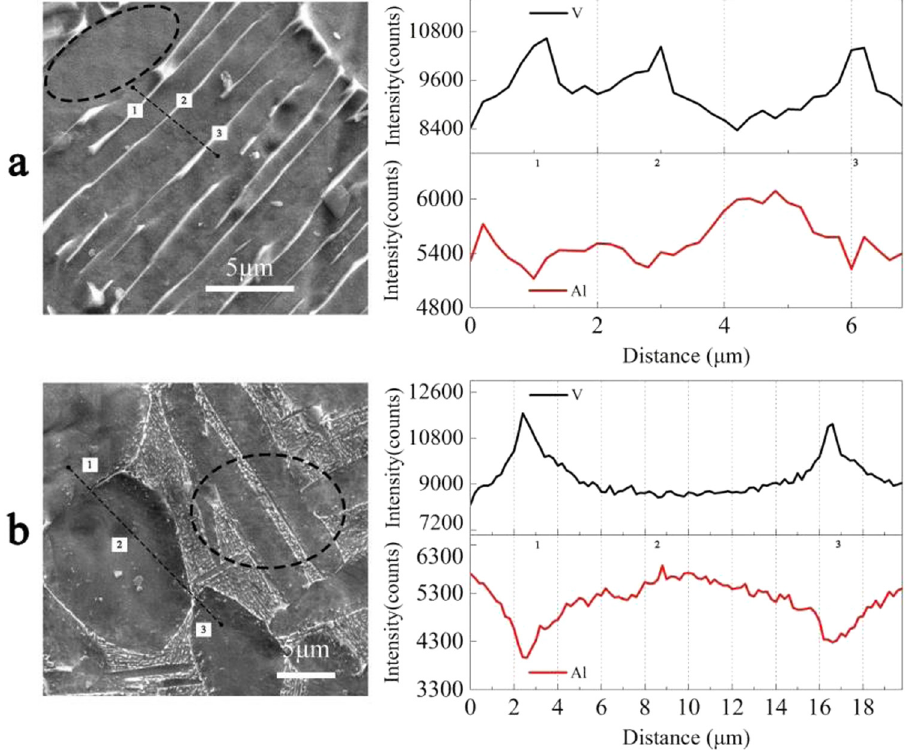
Figure 12: The line scan of energy - dispersive X - Ray spectroscopy on the SEM of the TC4 titanium alloy.